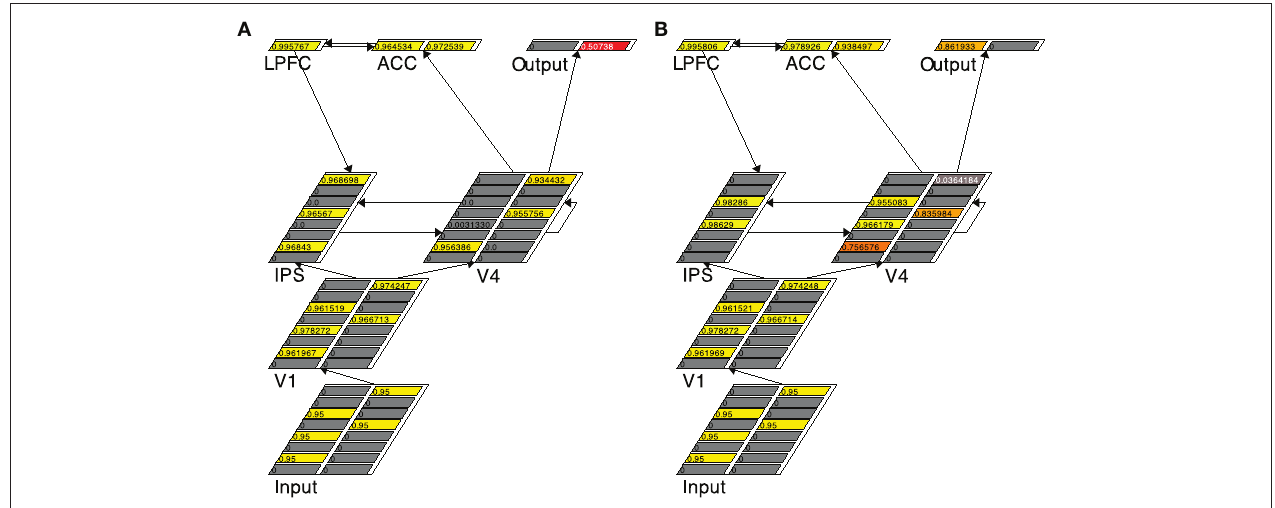
Figure 3 | Traces of the grouping search model running in a trial with three left-pointing and two right-pointing arrows, at two different time points: cycle 72 (A) and cycle 106 (B) . The number in each unit is its activation, also represented by